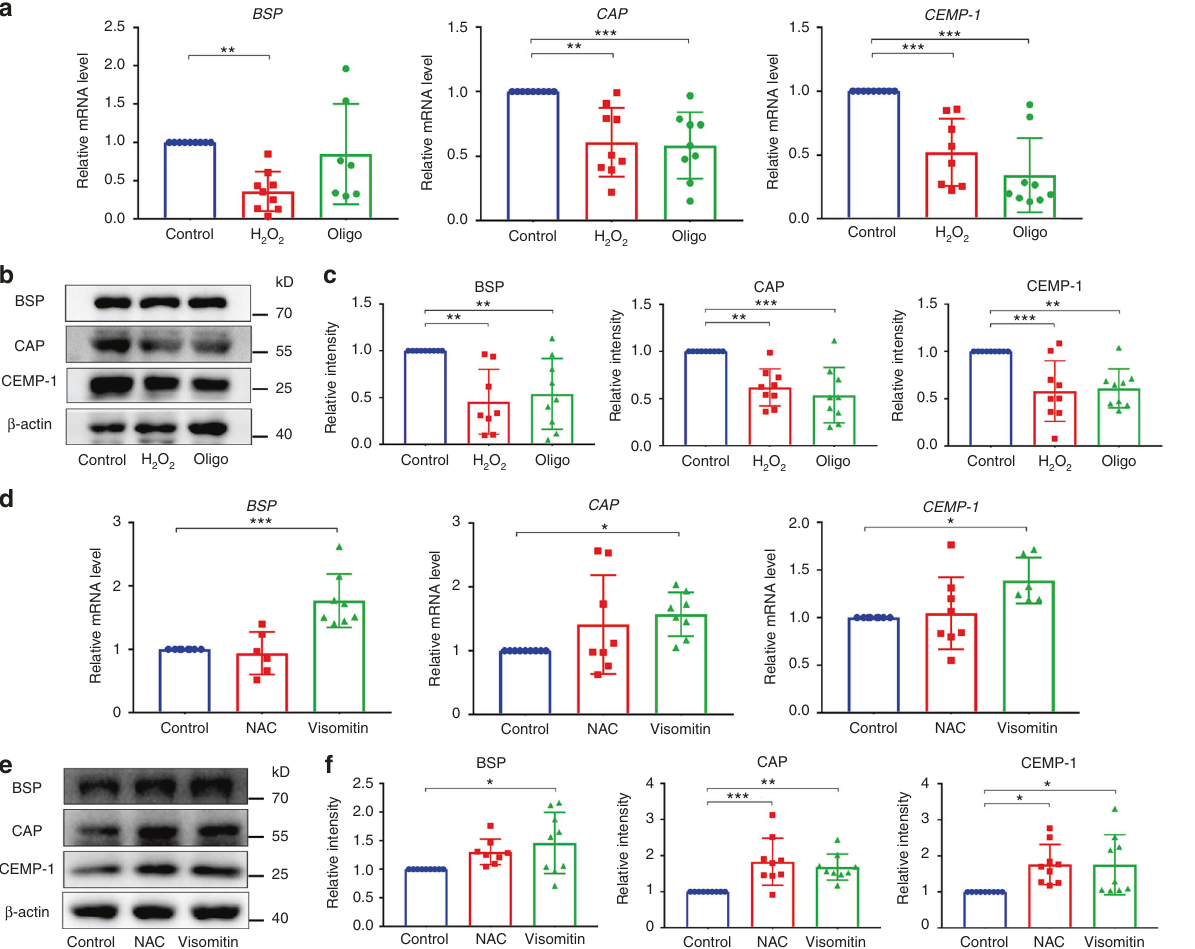
Fig. 3 Mitochondrial function is required for the cementoblastic differentiation of PDLSCs in either nonin fl ammatory or in fl ammatory environments. a – c Mitochondrial dysfunction impairs the cementoblastic differentiation of PDLSCs. The cells were incubated in medium with EMD (nonin fl ammatory environment). a Relative cementoblastic differentiation-related gene expression levels of BSP , CAP and CEMP-1 in the PDLSCs without (control) or with pretreatment with 10 μ mol·L − 1 H 2 O 2 (H 2 O 2 ) or 10 μ g·mL − 1 Oligo (Oligo) for 24 h (qRT-PCR). b Relative cementoblastic differentiation-related protein expression of BSP, CAP and CEMP-1 in the PDLSCs without (control) or with pretreatment with 10 μ mol·L − 1 H 2 O 2 (H 2 O 2 ) or 10 μ g·mL − 1 Oligo (Oligo) for 24 h (Western blot). c Semiquantitative analysis of the protein expression levels (normalized to β -actin) in terms of relative gray density. d – f Reversing in fl ammation-induced mitochondrial dysfunction rescued the cementoblastic differentiation of PDLSCs. The cells were incubated in medium with both in fl ammatory cytokines and EMD (in fl ammatory environment). d Relative cementoblastic differentiation-related gene expression levels of BSP , CAP and CEMP-1 in the PDLSCs without (control) or with pretreatment with 1 mmol·L − 1 NAC (NAC) or 20 nmol·L − 1 Visomitin (Visomitin) for 2 h (qRT-PCR). e Relative cementoblastic differentiation-related protein expression of BSP, CAP and CEMP-1 in the PDLSCs without (control) or with pretreatment with 1 mmol·L − 1 NAC (NAC) or 20 nmol·L − 1 Visomitin (Visomitin) for 2 h (Western blot). f Semiquantitative analysis of protein expression levels (normalized to β -actin) in terms of relative gray density. The data are shown as the mean ± SD for n from 6 to 9; * P < 0.05, ** P < 0.01 and *** P < 0.001 indicate signi fi cant differences between the indicated